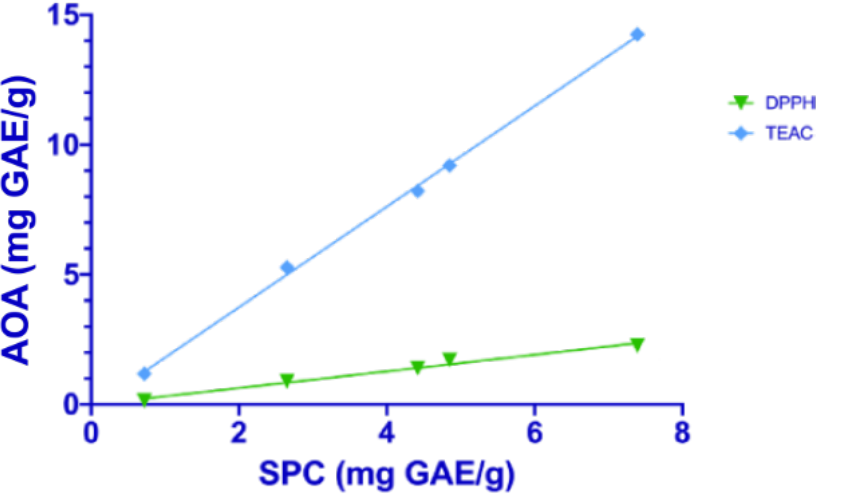
Figure 1. Linear regression between soluble phenolic content (SPC) and the in vitro antioxidant activity (AOA), measured with DPPH (green line) and TEAC assays (blue line) in rice samples.